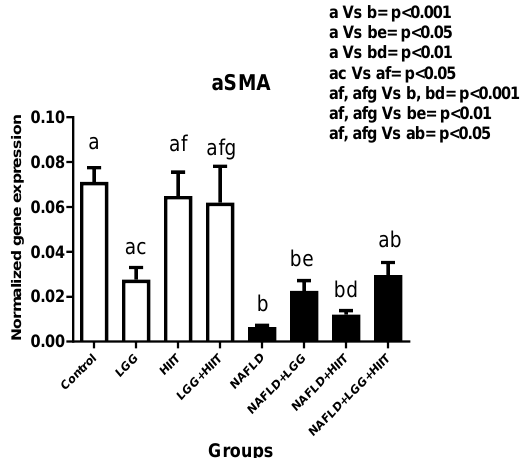
Figure 5: Liver tissue alpha-smooth muscle actin (α-SMA) mRNA expression in different groups of study. All values are the mean ± SD (n = 10 per group). Values with different superscripts are sig- nificantly different, p < 0.05. LGG: Probiotic